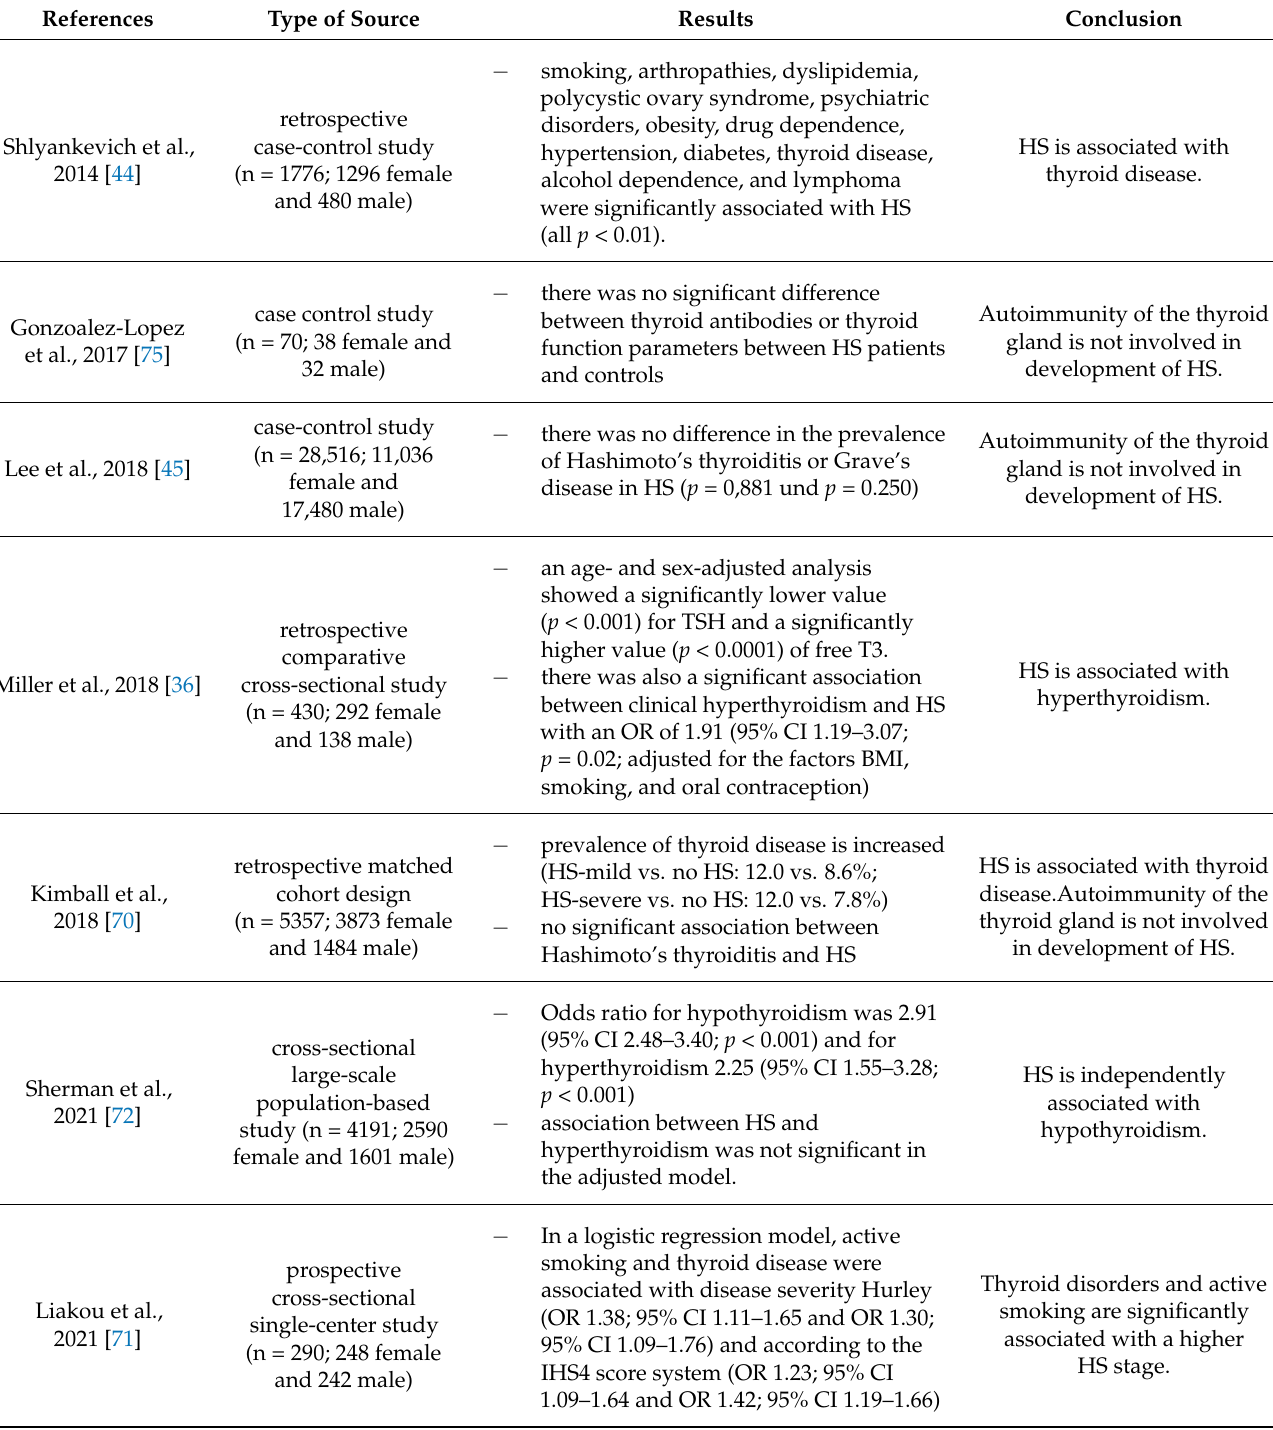
Table 8. Current findings about thyroid function in